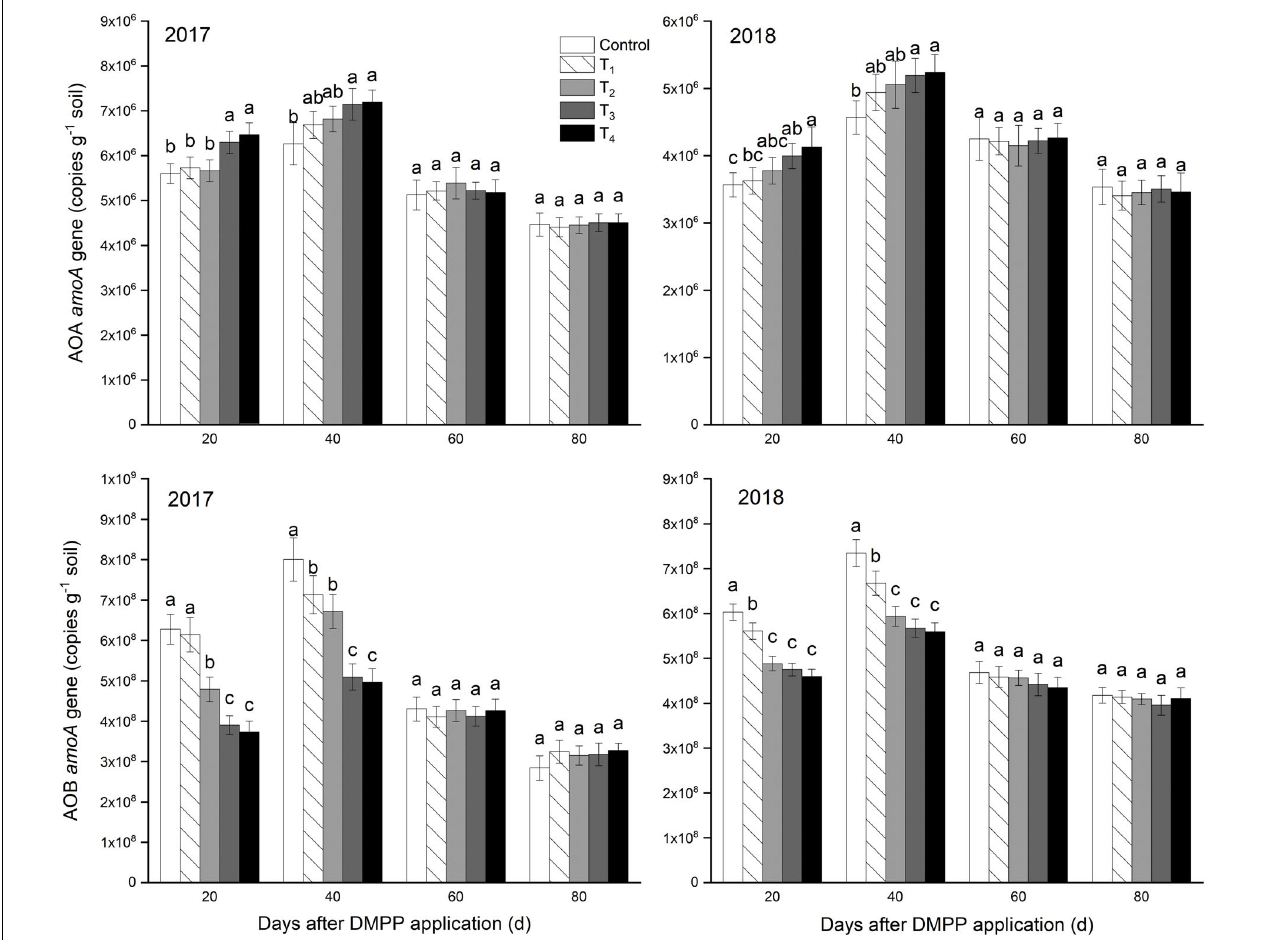
FIGURE 2 | Abundances of amoA genes of ammonia-oxidizing archaea (AOA) and bacteria (AOB). The vertical bar indicates the standard deviation of three replications. Different letters indicate statistically significant differences ( P <